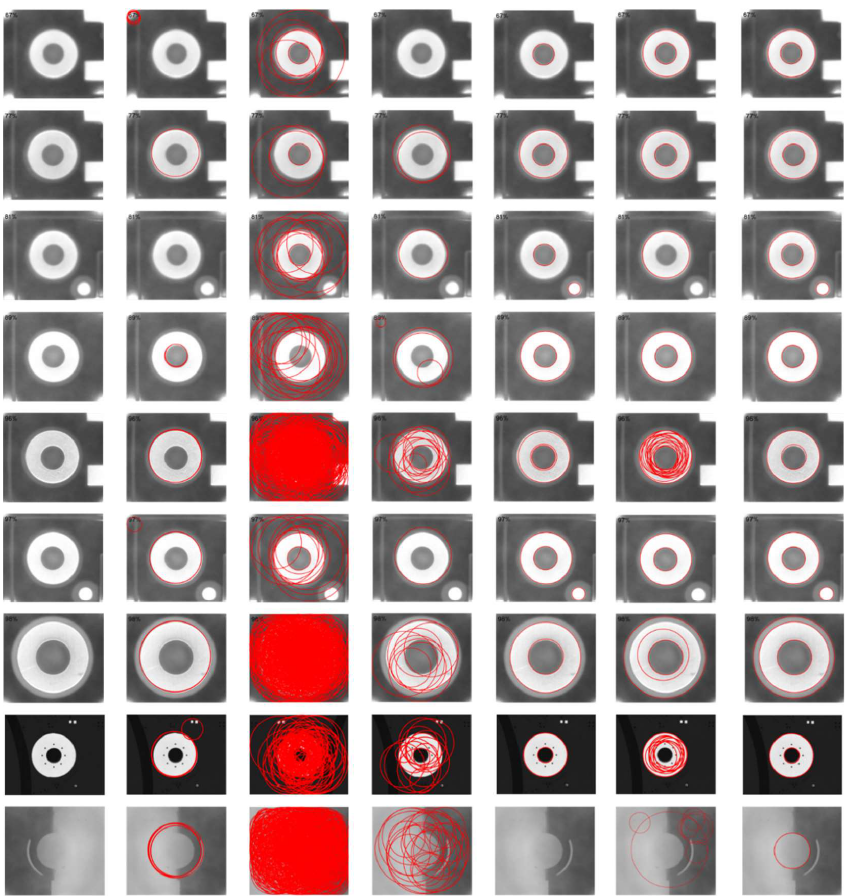
Figure 9. Circle detection results on the dataset PCB, which is widely used by other algorithms. From the left to right columns: input image, RHT, RCD, CACD, Jiang, Wang and ours. As can be seen, the proposed method obtains better performance than the others. Table 8. Result on the dataset